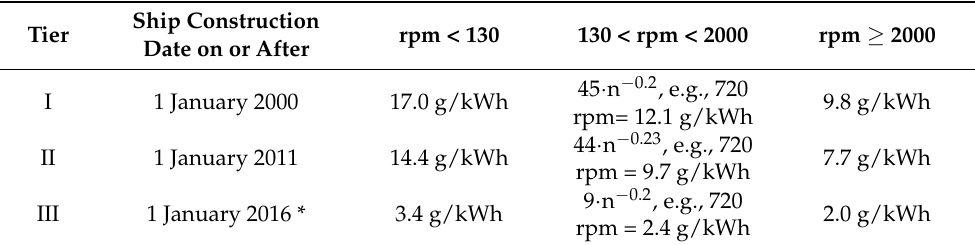
Table 1. Different tiers of control apply based on the ship construction date and engine revolution per minutes